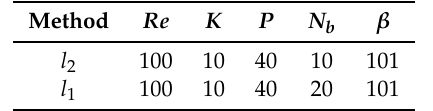
Table 2. Problem design for l 1 − l 2 comparison.